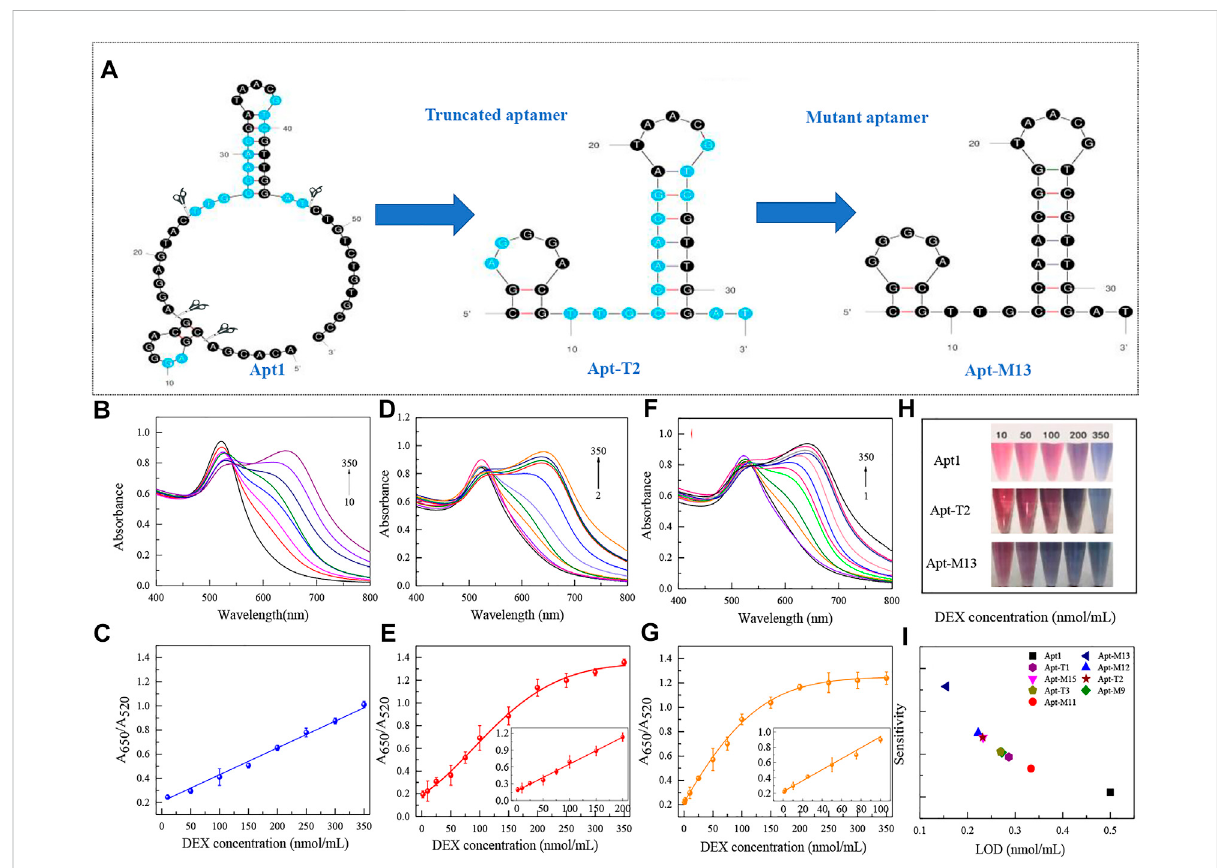
FIGURE 3 SecondarystructureoftheoriginalsequenceApt1,andthecorrespondingtruncatedandmutantaptamers (A) .UVabsorptionspectraoforiginal aptamer-based sensing systems at DEX concentrations of 10 – 350 nmol/ml (B) and linear responses at different concentrations (C) . UV absorption spectra of truncated aptamer-based sensing systems at DEX concentrations of 2 – 350 nmol/ml (D) and linear responses at different concentrations (E) . UV absorption spectra of mutant aptamer-based sensing systems at DEX concentrations of 1 – 350 nmol/ml (F) and linear responses at differentconcentrations (G) .ColorresponsesofthreeaptamersatdifferentDEXconcentrations (H) .Comparisonofanalyticalperformancebasedon each aptamer in a colorimetric sensor (I) .